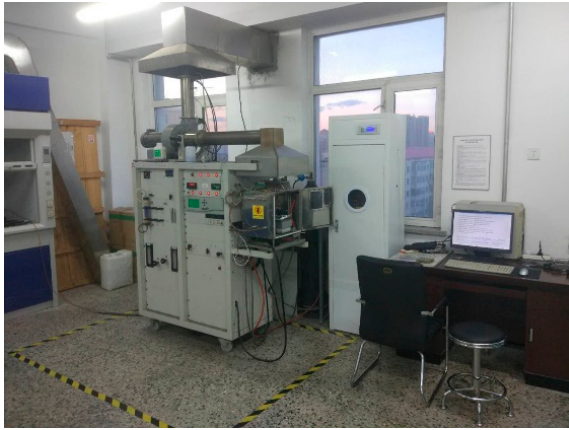
Figure 6. Appearance and components of the cone calorimeter.